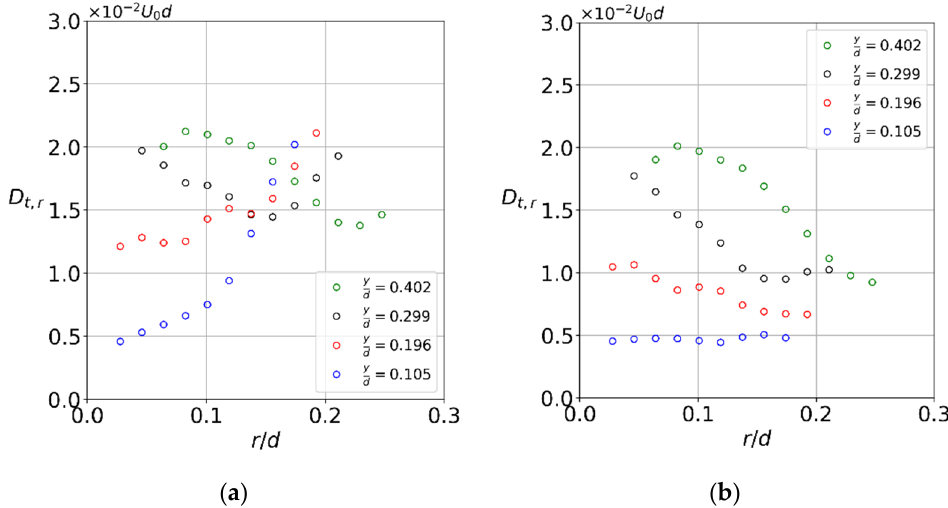
Figure 19. Turbulent diffusion coefficient for ( a ) total and ( b ) stochastic turbulent fluctuations for gas turbine swirler.